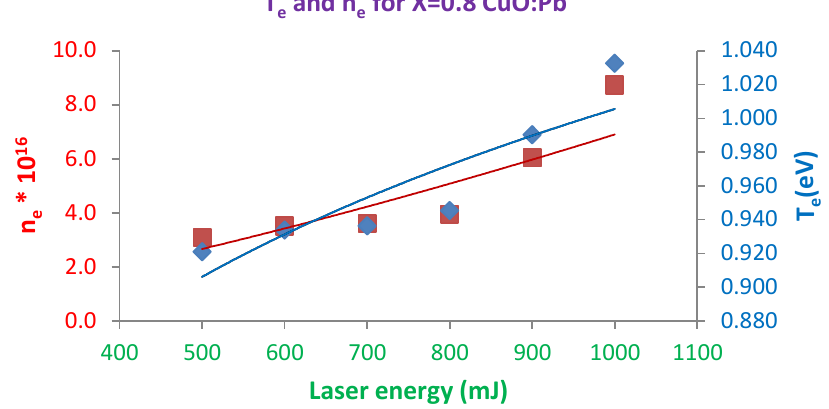
Fig.8: The variation of (T